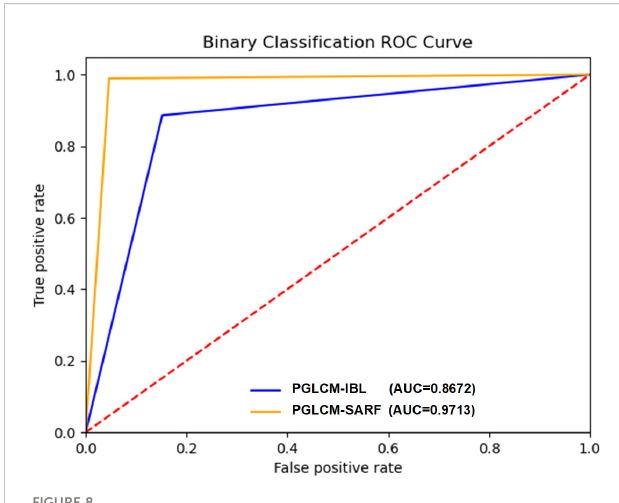
FIGURE 8 ROC curves of PGLCM-SARF and PGLCM-IBL for binary classi fi cation